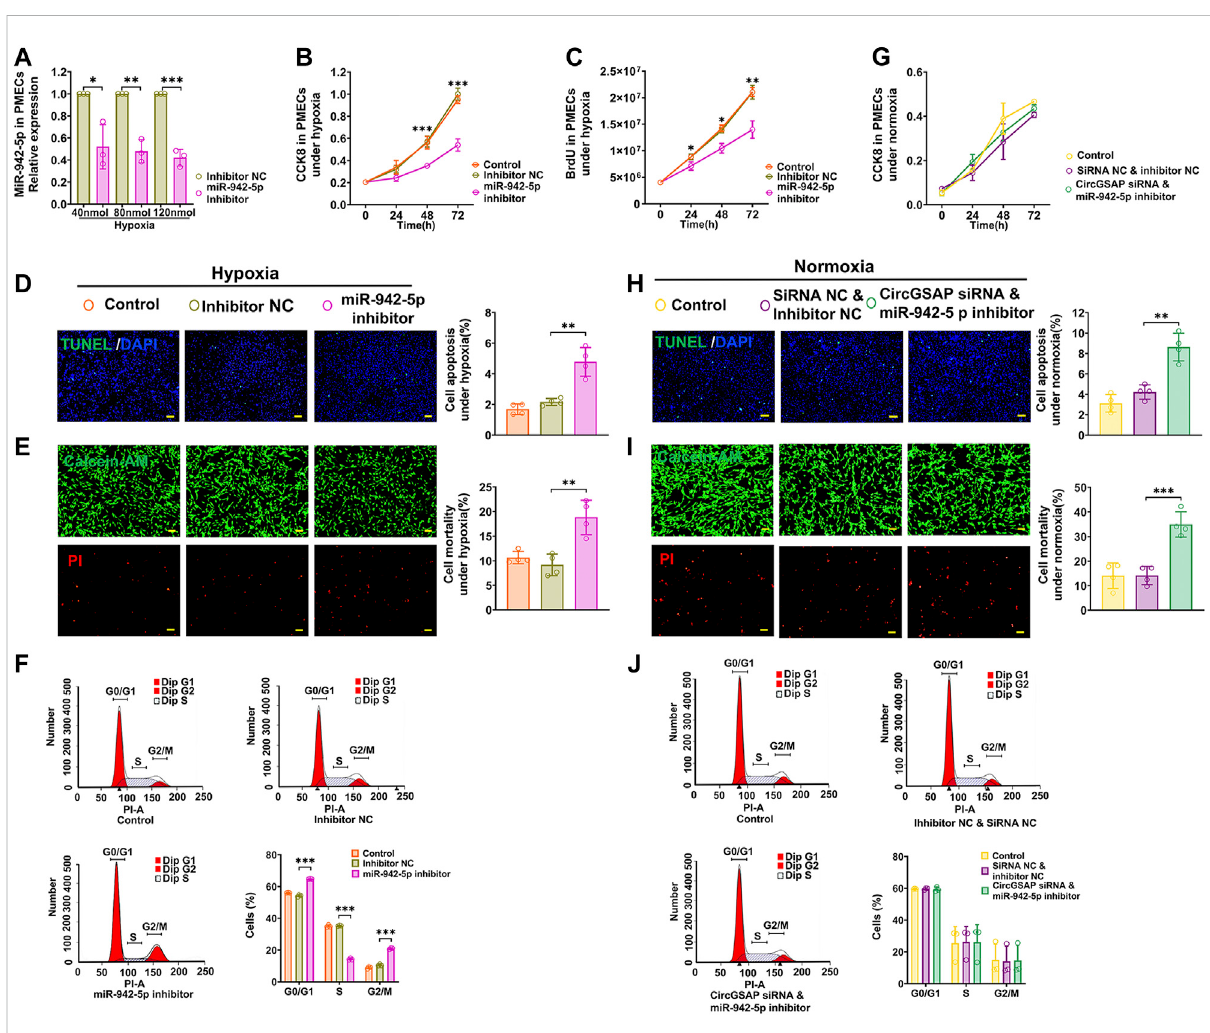
FIGURE 4 MiR-942-5p inhibitors reversed the effects of circGSAP siRNA on PMECs proliferation, apoptosis and cell cycle. (A) Expression levels of miR- 942-5p in PMECs treated with miR-942-5p inhibitor underhypoxia ( n = 3). (B – F) Cell proliferation analysis, apoptosis analysis, mortality analysis ( n = 4) and cell cycle analysis ( n = 3) of PMECs with miR-942-5p inhibitor under hypoxia. (G – J) Cell proliferation analysis, apoptosis analysis, mortality analysis ( n =4) and cell cycle analysis ( n = 3) ofPMECs with co-transfecting circGSAP siRNAand miR-942-5pinhibitorunder normoxia. All data are presented as the mean ± SEM. (scale bar, 100 μ m). * p < 0.05; ** p < 0.01; *** p <